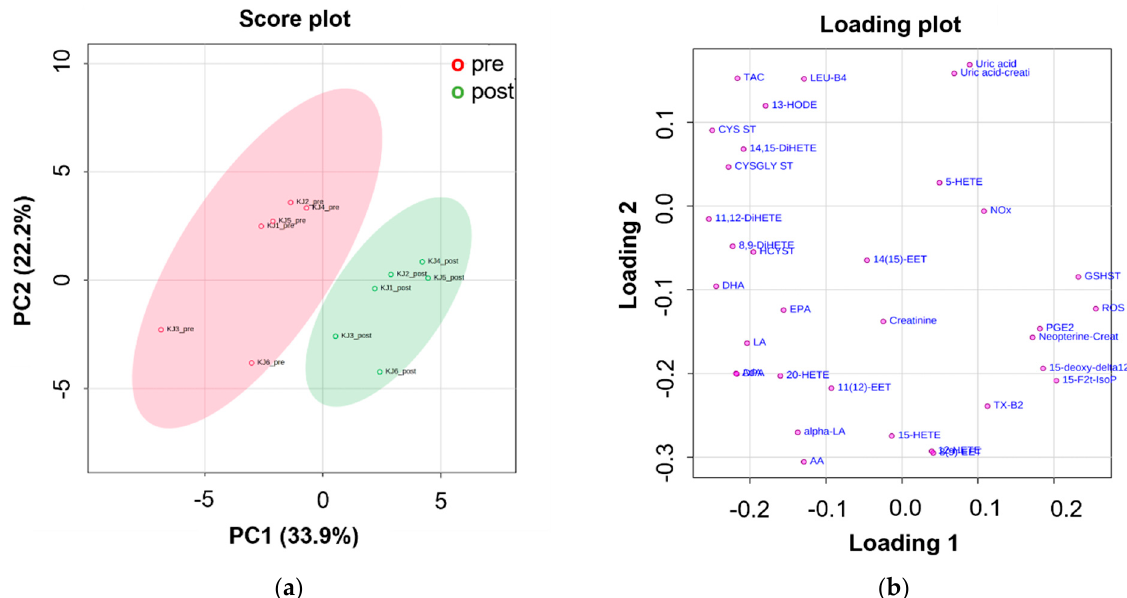
Figure 2. ( a ) Score plot and ( b ) loading plot of PCA performed on the overall dataset. Red and green symbols represent trekkers pre- and post-high-altitude trek, respectively. Data were pre-processed (i.e., square root transformation and data autoscaling) prior to the multivariate analysis. Table 2. Oxylipin mean concentration levels measured pre- and post-high-altitude trek. Pre-Altitude Trek Post-Altitude Trek Compound *